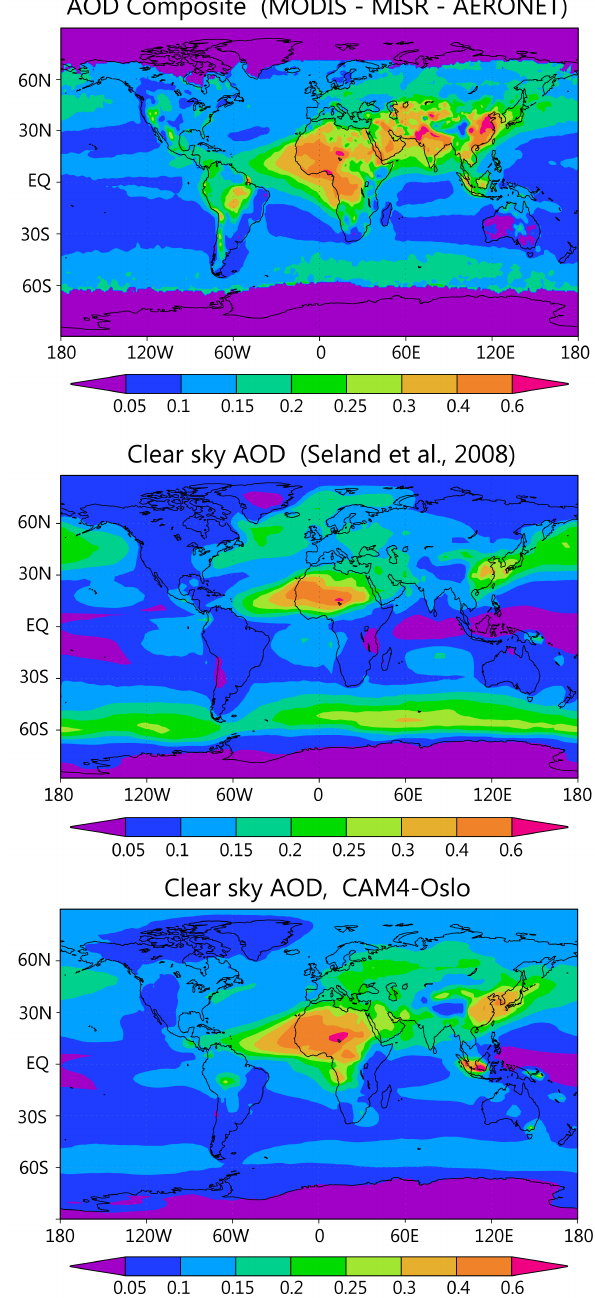
Fig. 7. Annually averaged clear-sky aerosol optical depth (AOD) at 550nm from ground- and satellite-based retrievals in the upper panel (S. Kinne, personal communication, 2007), as calculated in Seland et al. (2008) in the middle panel, and calculated with CAM4- Oslo ( Ctrl ) in the lower